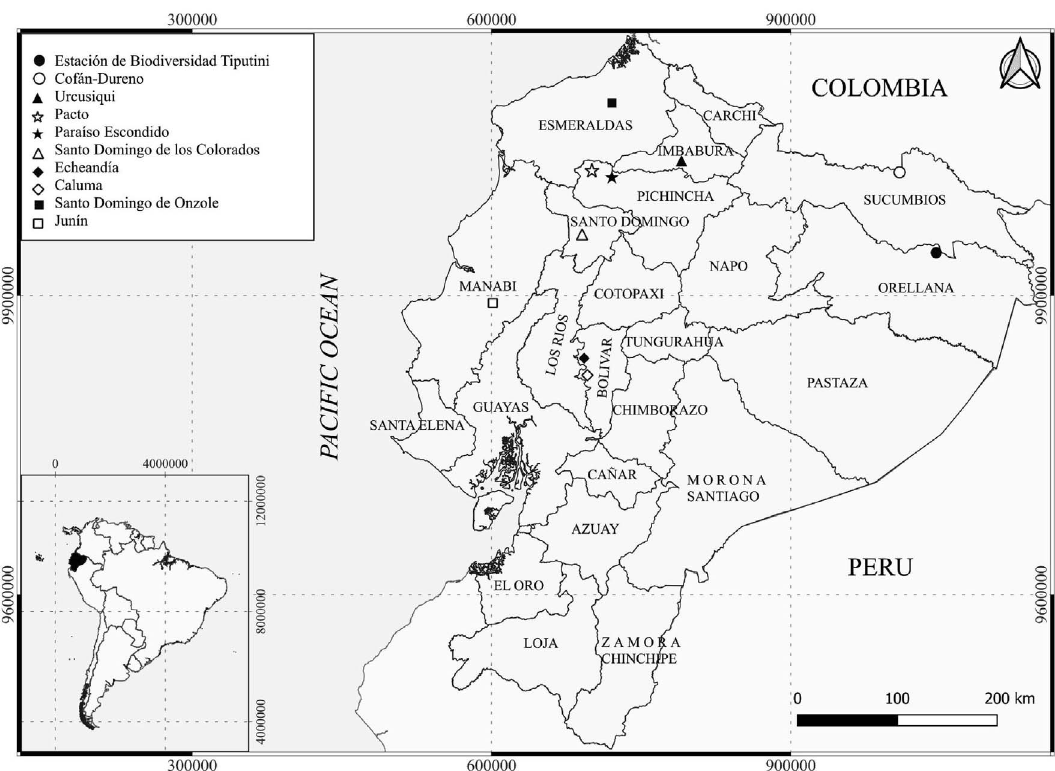
Figure 1. Sites of entomological